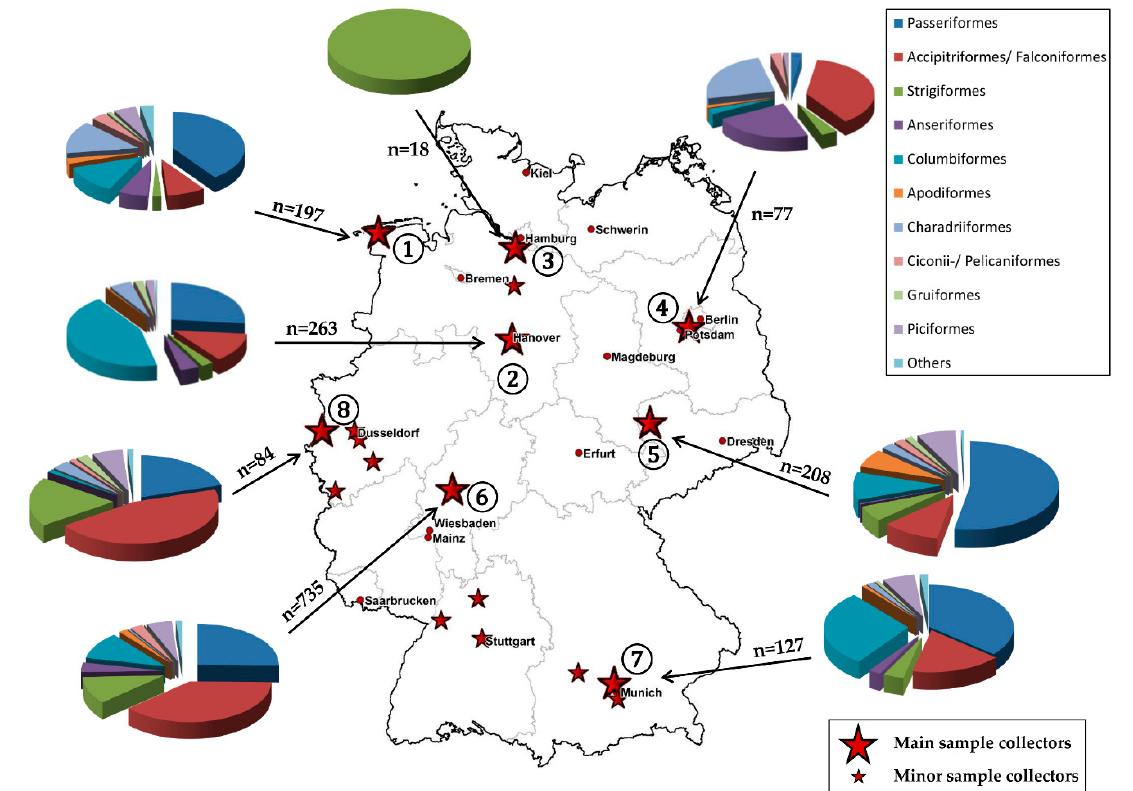
Figure 1. Total number of samples (first sample panel) collected in 2017 and 2018 per sampling site divided into the different zoological bird orders (big red stars = main sample collectors, small red stars = minor sample collectors). The encircled numbers next to the sample collectors allow a geographical allocation to the respective sample collector: 1 (cid:79) “Seehundstation Nationalpark-Haus Norden-Norddeich”; 2 (cid:79) “Clinic for Small Mammals, Reptiles, and Birds of the University of